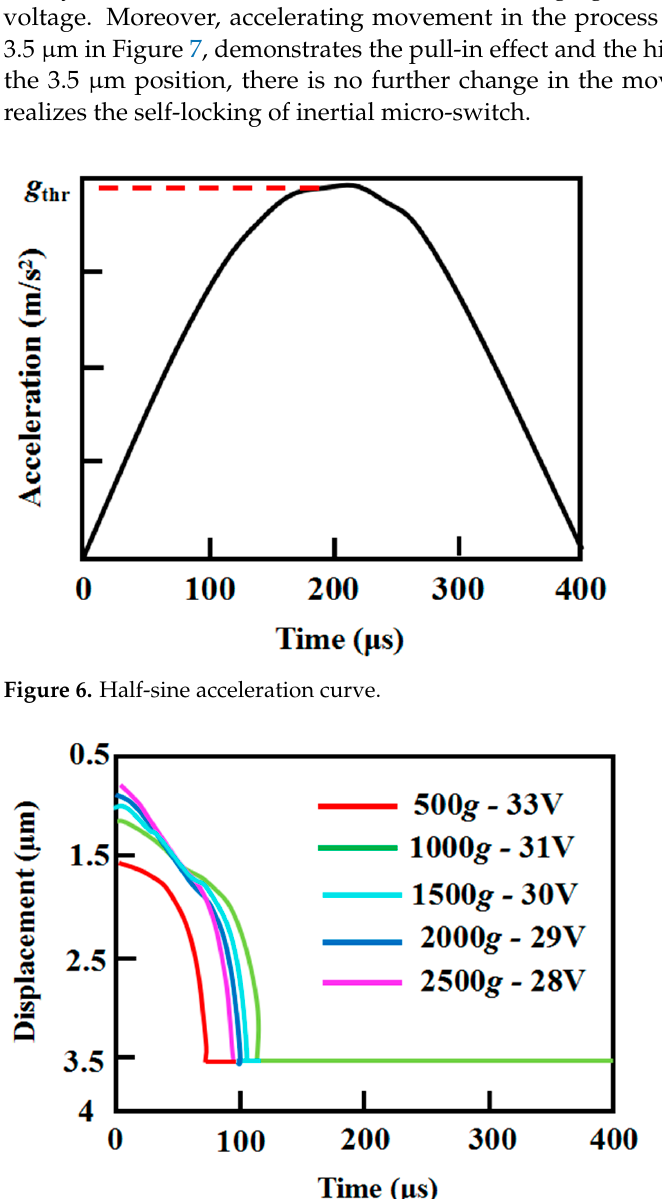
Figure 7. Electromechanical coupling of inertial switch.